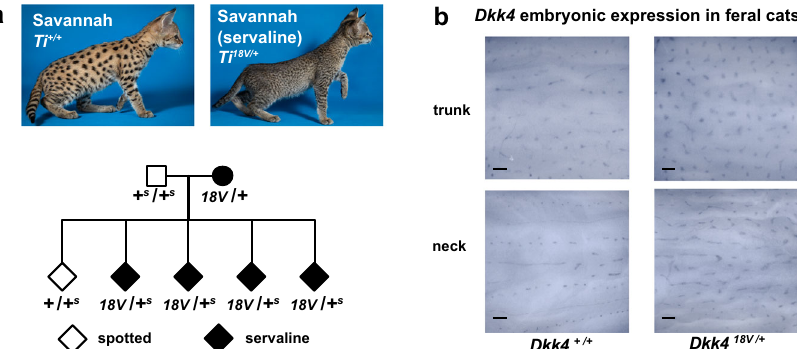
Fig. 6 Effect of a Dkk4 mutation on color pattern and Dkk4 expression in fetal skin. a Phenotype of spotted and servaline Savannah cats (from Jamila Avaega, with permission), and cosegregation of those phenotypes with Dkk4 p.Ala18Val. The domestic cat and Serval non-mutant alleles are represented by + and + s , respectively. b Altered Dkk4 expression (dark markings) in whole-mount preparations from stage 17 fetal skin. Whole-mount expression of Dkk4 was made on multiple body regions from the trunk and neck of paired + / + and + /A18V embryos. Scale bar, 300 μ